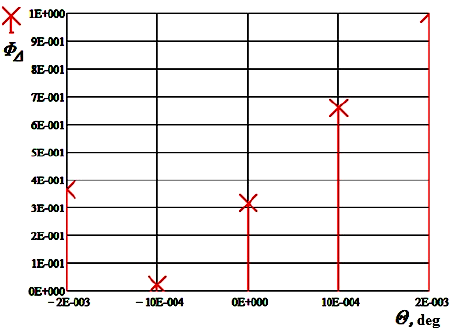
Fig. 7. The differential radiation pattern of the experimental DAA, sample discretion 0.1 deg.